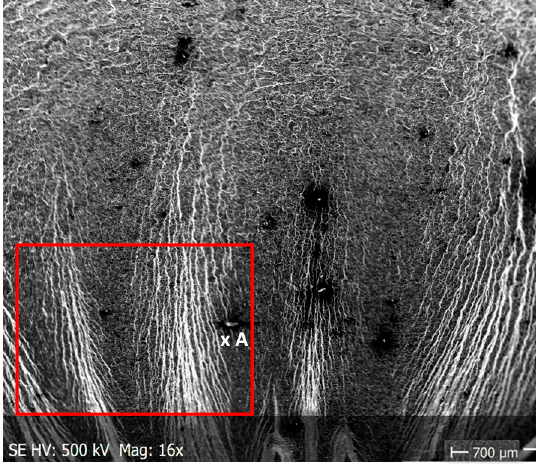
Figure 9. ( a – c ) Fracture images within area A (Figure 8).